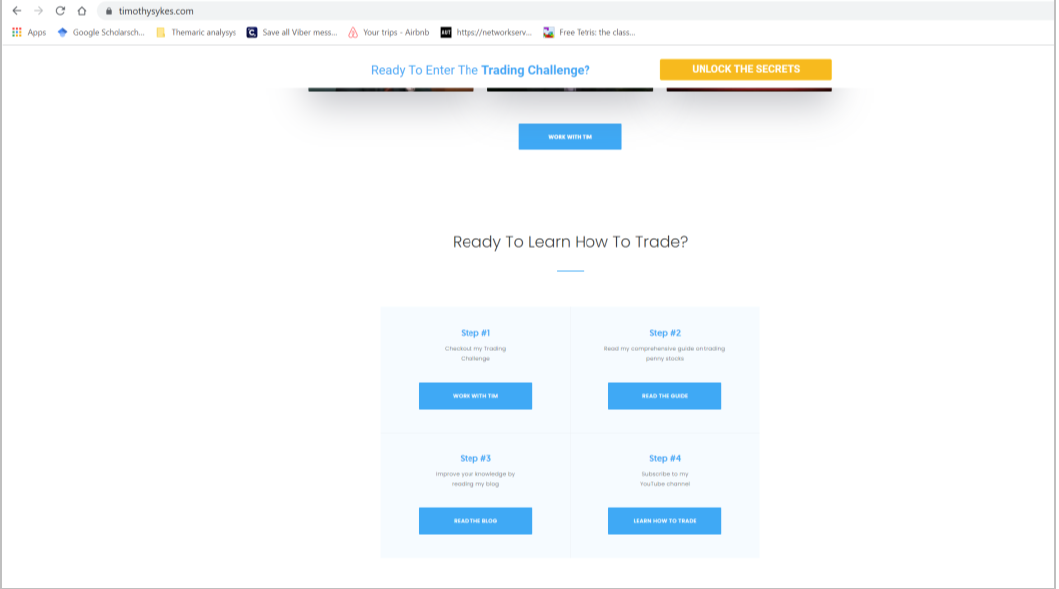
Figure 1. A blogger’s site (Available online: https://www.timothysykes.com/, accessed on 23 December 2021).